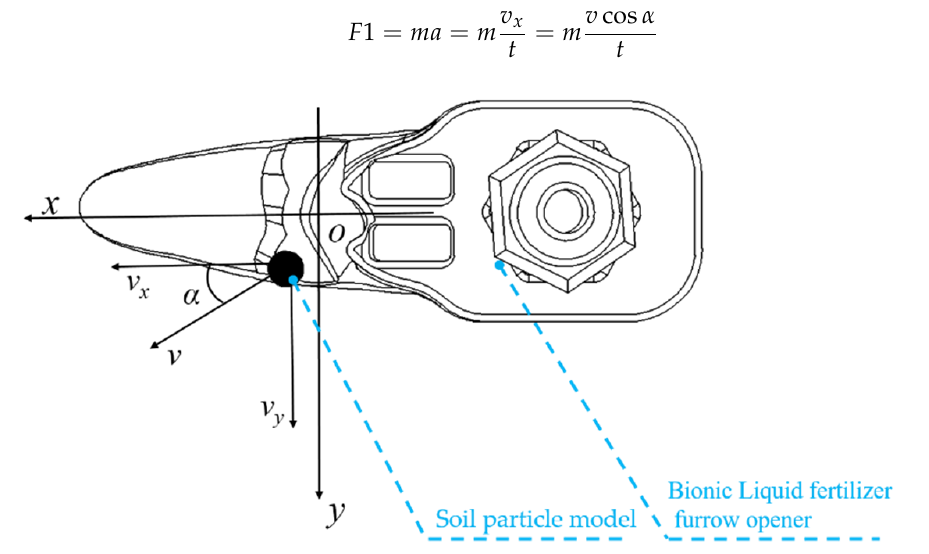
Figure 7. Liquid fertilizer furrow opener structure.